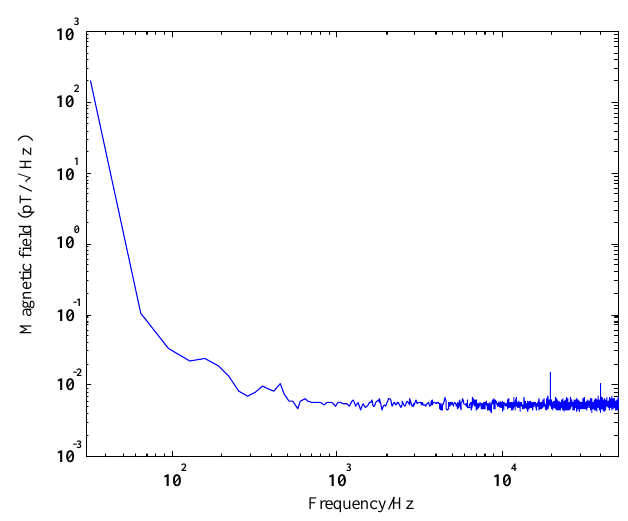
Figure 2. Magnetic noise spectra of the mobile SQUID system measured inside a magnetically shielded room